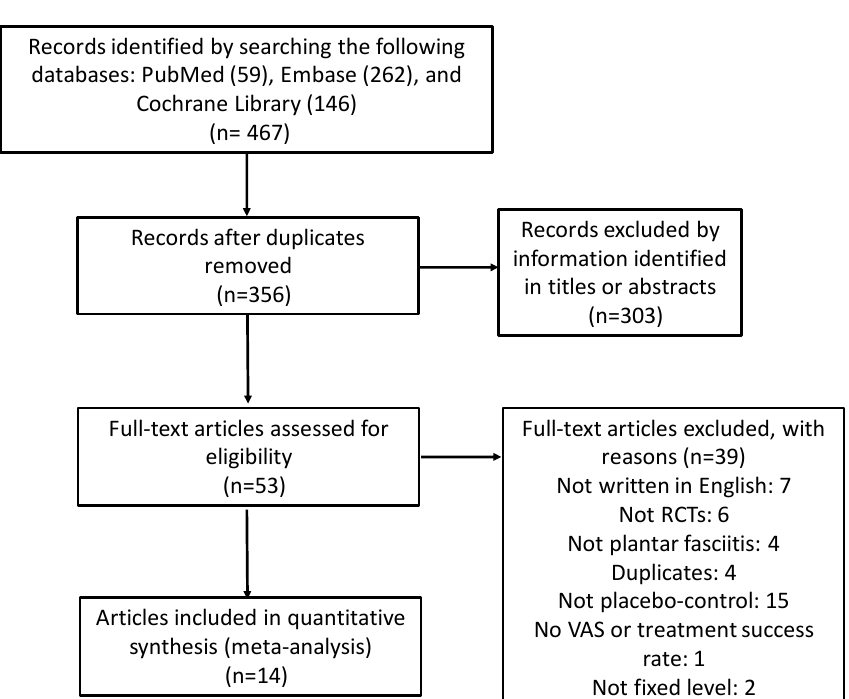
Figure 1. Flow diagram of selection process for relevant article identification.